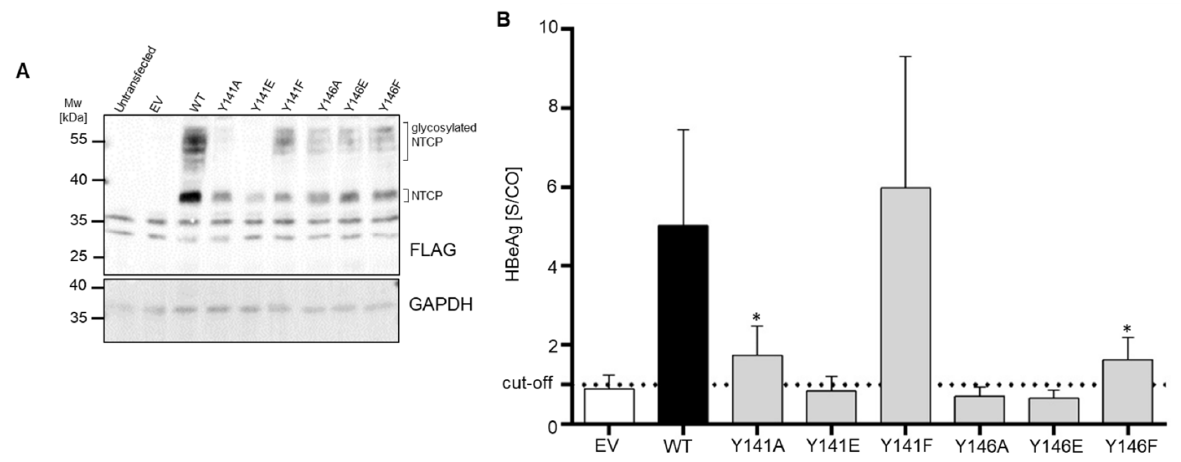
Figure 6. In vitro HBV infection of HepG2 cells expressing wt NTCP or the NTCP mutants Y141A, Y141E, Y141F, Y146A, Y146E, and Y146F. HepG2 cells were transiently transfected with the indicated constructs. ( A ) Protein expression of the NTCP wt and mutants in HepG2 cells as demonstrated by Western blotting using anti-FLAG antibody. Expression of GAPDH served as loading control. MW, molecular weight; EV, empty vector. ( B ) Forty-eight h after transfection, cells were infected with HBV for 16 h. At 12 days post infection, cell culture supernatants of HBV infected cells were collected and de novo production of HBeAg was qualitatively evaluated in a commercial HBeAg assay. Data represent means ± SD of three independent experiments. S/CO, signal-to-cut-off ratio. EV, empty vector. * Significantly lower compared to wt NTCP with p < 0.001 according to one-way ANOVA with Dunnett’s multiple comparison post-hoc test.